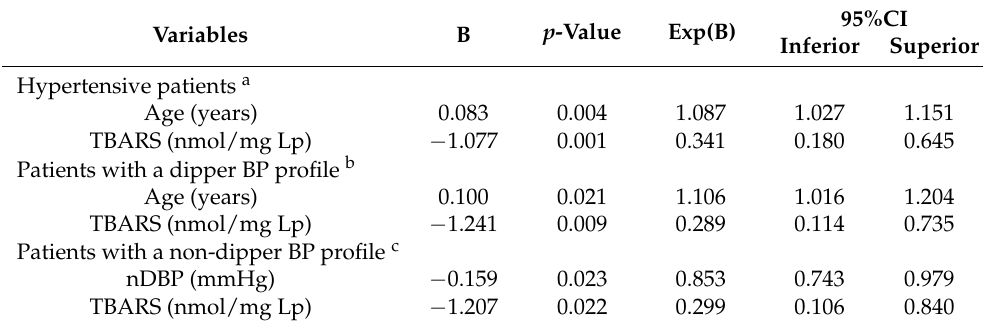
Table 4. Binary logistic regression models for the bedtime use of RAAS